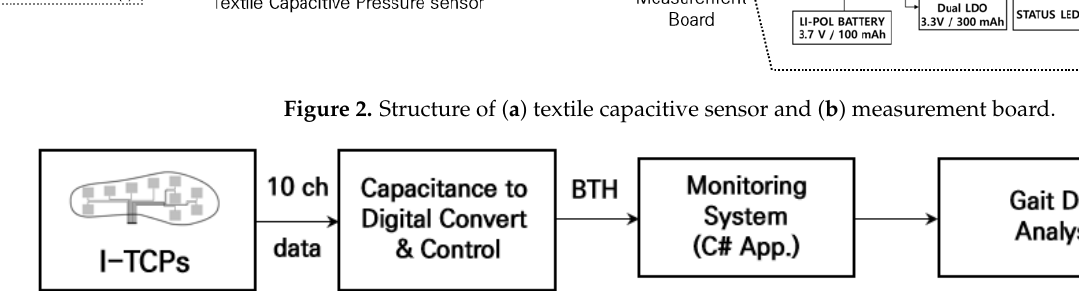
Figure 3. Gait data acquisition process.